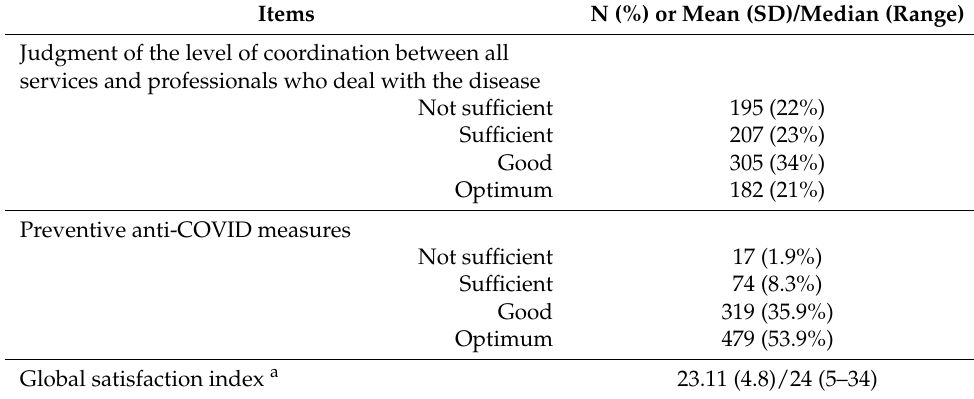
Table 3. Cont. Items N (%) or Mean (SD)/Median (Range) Judgment of the level of coordination between all services and professionals who deal with the disease Not sufficient 195 (22%) Sufficient 207 (23%) Good 305 (34%) Optimum 182 (21%) Preventive anti-COVID measures Not sufficient 17 (1.9%) Sufficient 74 (8.3%) Good 319 (35.9%) Optimum Global satisfaction index a